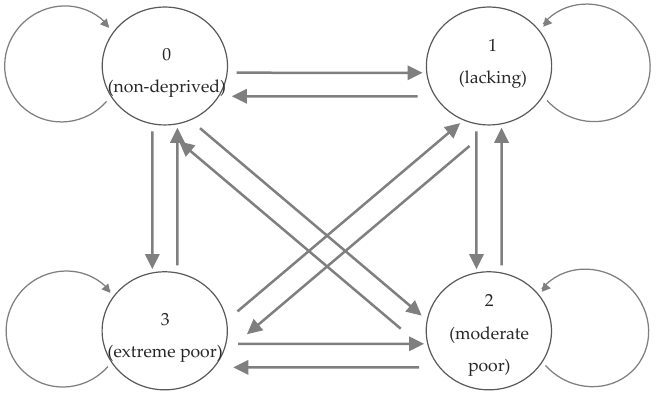
Figure 1. A four-state Markov model for diabetics and non-diabetics.